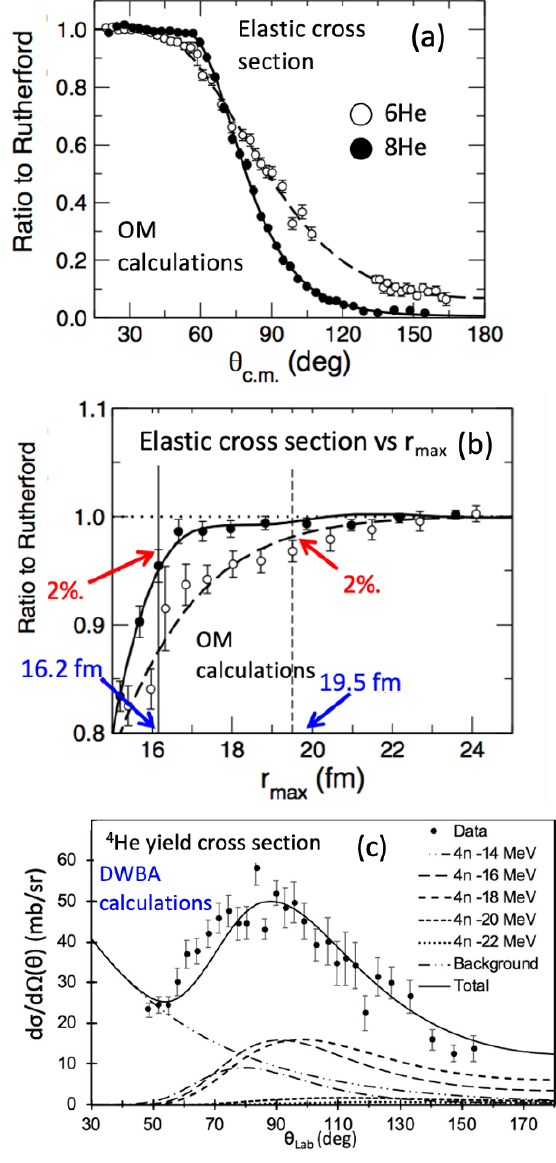
Fig. 5. Experimental angular distribution of the elastic scattering cross section over Rutherford for 8 He (black filled circles) and 6 He (white circles) with a 208 Pb target at E Lab = 22 MeV [25]. The solid and dashed lines are OM calculations for 8 He and 6 He, respectively. (b) As before, but as a function of the distance of closest approach r max . (c) Experimental angular distribution of the cross section for 4 He production in the scattering of 8 He + 208 Pb at E Lab = 22 MeV. The data can be reproduced by DWBA calculations assuming 4n cluster transfer to high excited states in 212 Pb by fitting the relevant spectroscopic factors [26]. The solid line is thus a fit of the data, and the other lines the partial contributions from different excited states in 212